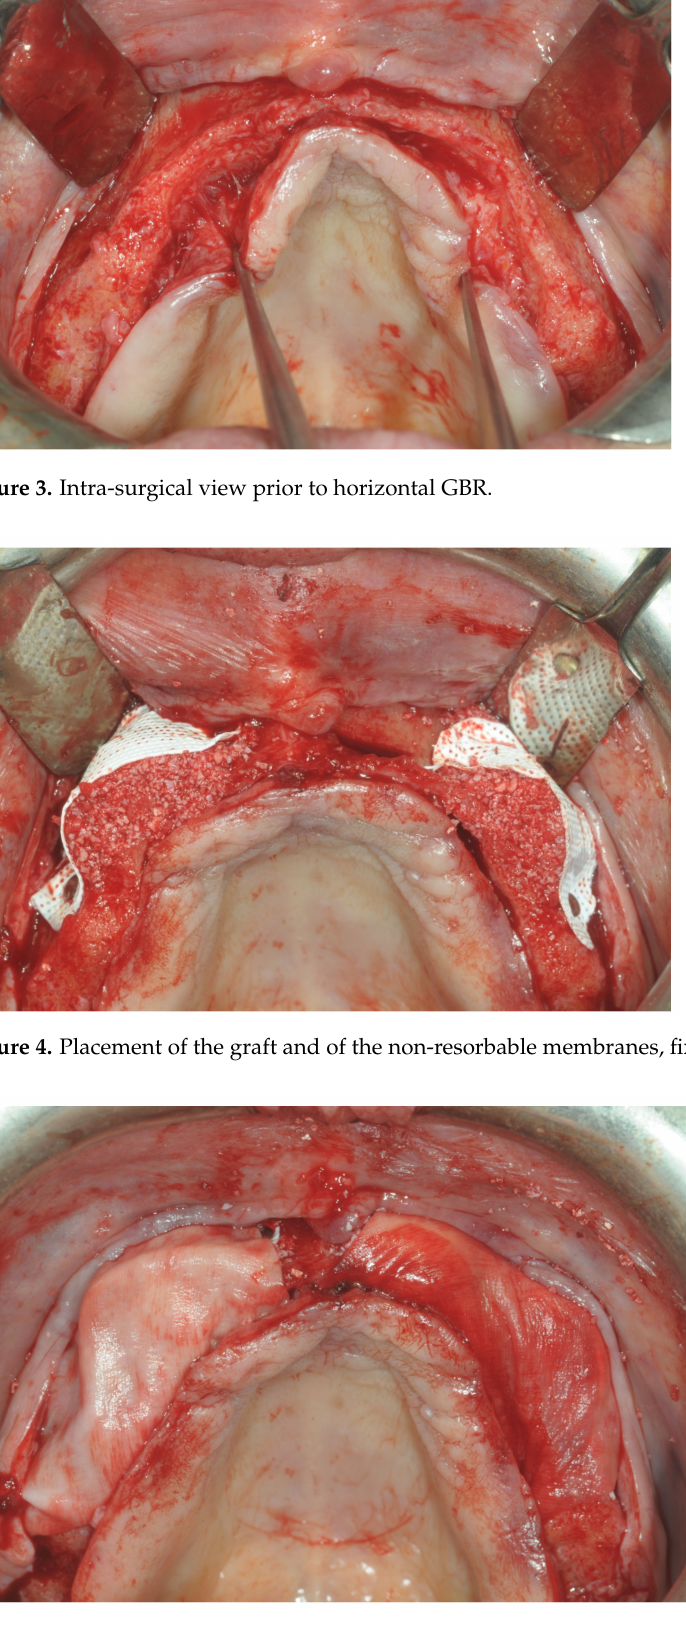
Figure 5. Placement of the resorbable membranes to cover the occlusal portion of the bone